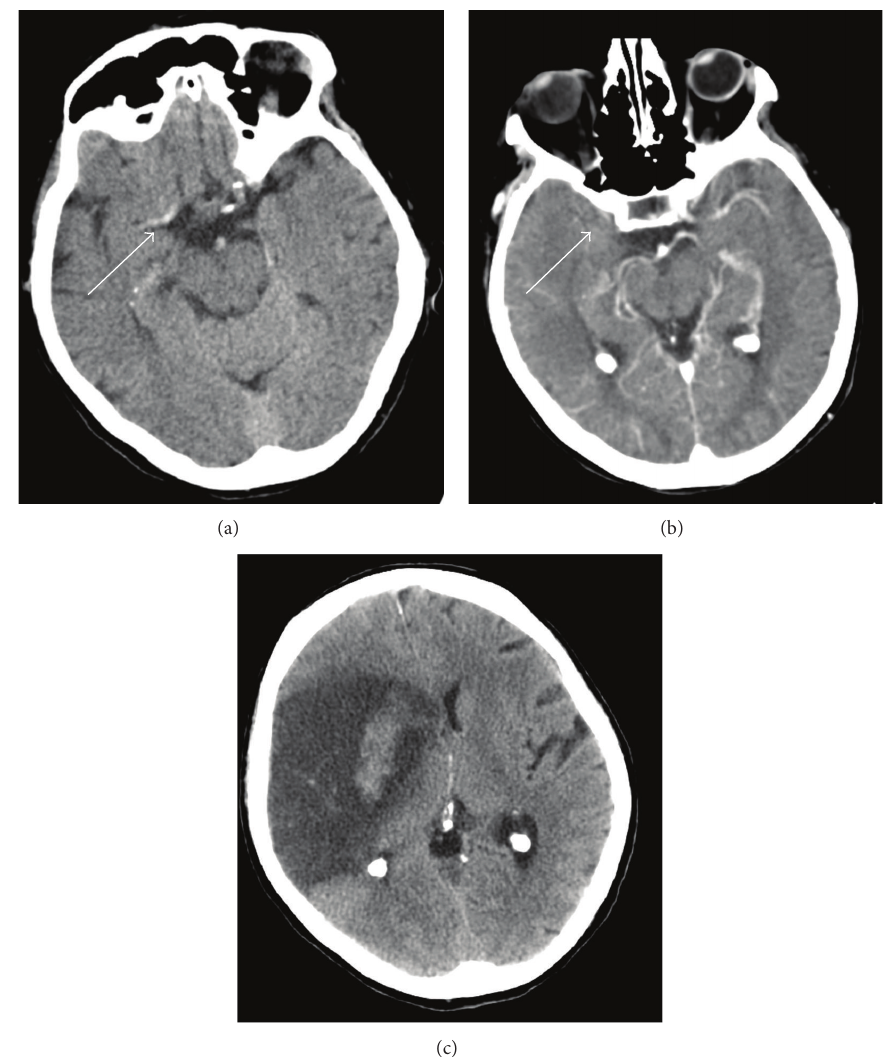
Figure 1: Imaging of initial ischemic stroke. (a) CT without contrast, showing dense right MCA (white solid arrow) and loss of differentiation of the grey-white junction on theright. (b)CT angiography, revealing occlusion of theright MCA(whitesolid arrow). (c) CTwithout contrast, showing subsequent hemorrhagic transformation of the